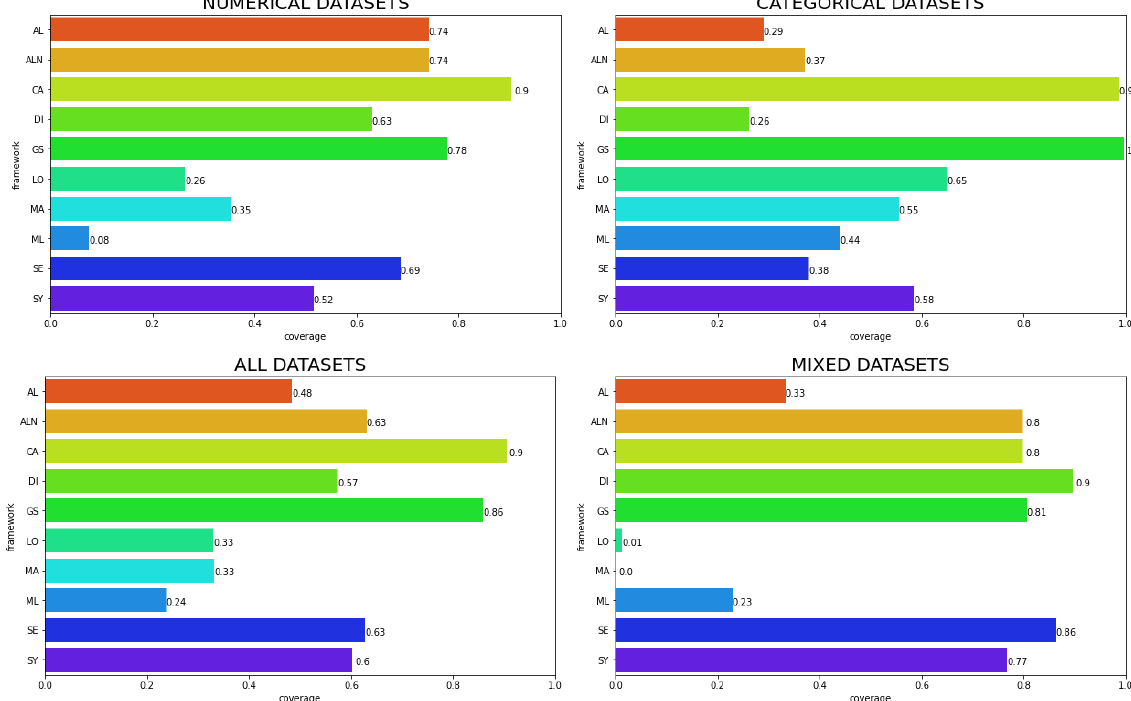
Figure 6. Proportion of factual examples that generates counterfactual explanations. Each chart represents a dataset type; the bottom left chart analyzes all datasets used in the study.